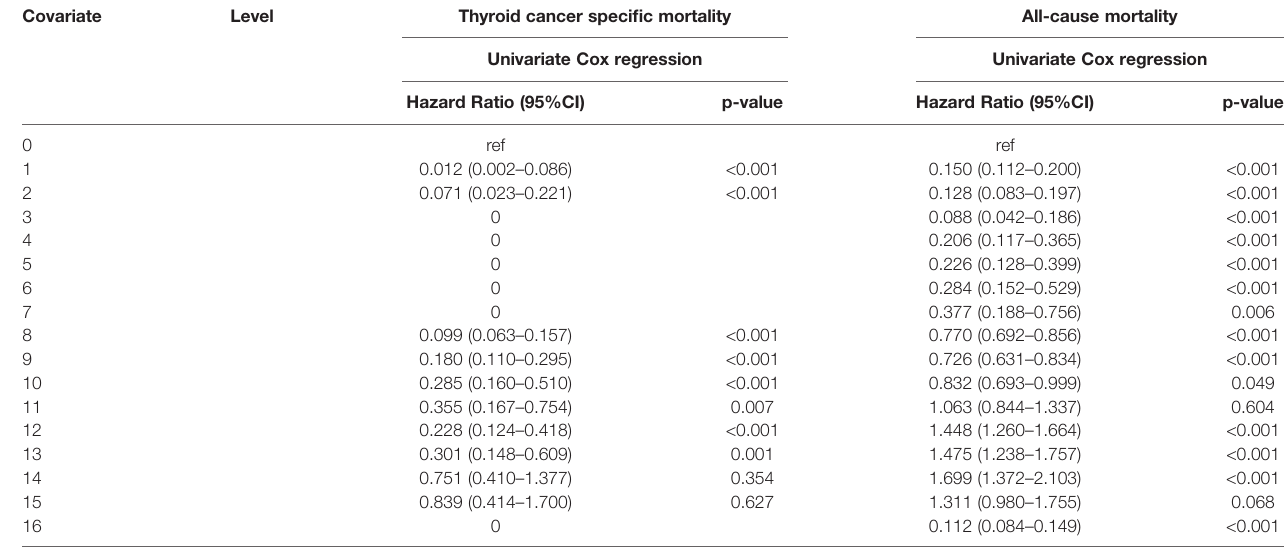
TABLE 4 | Analysis of si-DTC patients and patients with total T3 (ETE+, N1, M1). Covariate